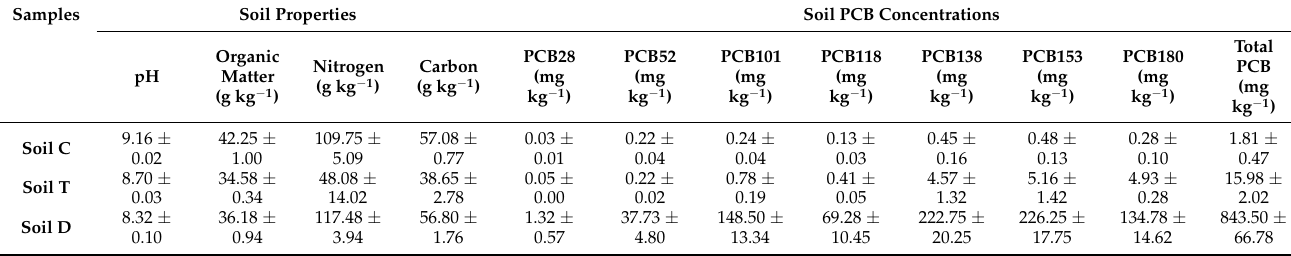
Table 1. Physico-chemical characteristics of PCB-polluted soils. The results are expressed as means ± standard deviation ( n = 4). The concentrations of each of the 7 PCB congeners and the total concentrations of all the 7 congeners are indicated. Samples Soil